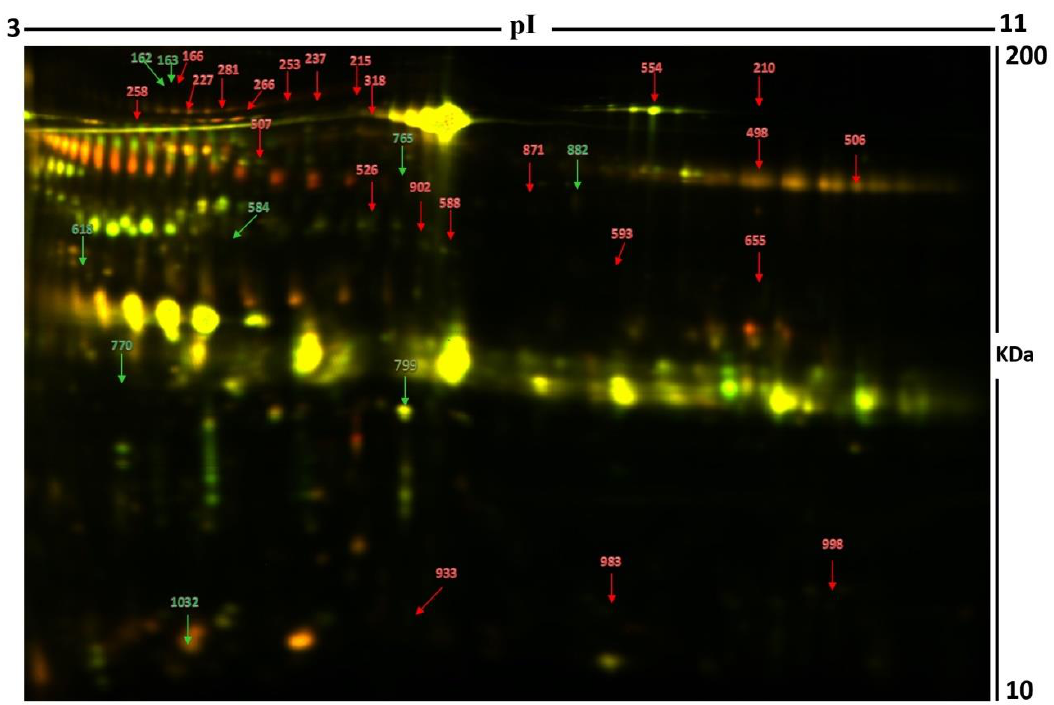
Figure 2. Representative image of the gel depicting the protein spots identified with MALDI-TOF (MS) in the urine samples. Numbered spots indicate proteins that were significantly changed (over 1.5-fold change, p < 0.05) between the hyperthyroid and euthyroid states. The red and green arrows indicate the upregulated and downregulated proteins respectively between the two states. Table 2. Identified proteins, with changes in abundance of significantly differentially abundant proteins between hy- perthyroid and euthyroid states in urine samples. Table 2 shows values for the average ratio between the two states, with their corresponding levels of fold changes and one-way ANOVA ( p -value < 0.05) using 2D-DIGE. (Analysis type: MAL- DI-TOF; database: SwissProt; taxonomy: Homo sapiens).